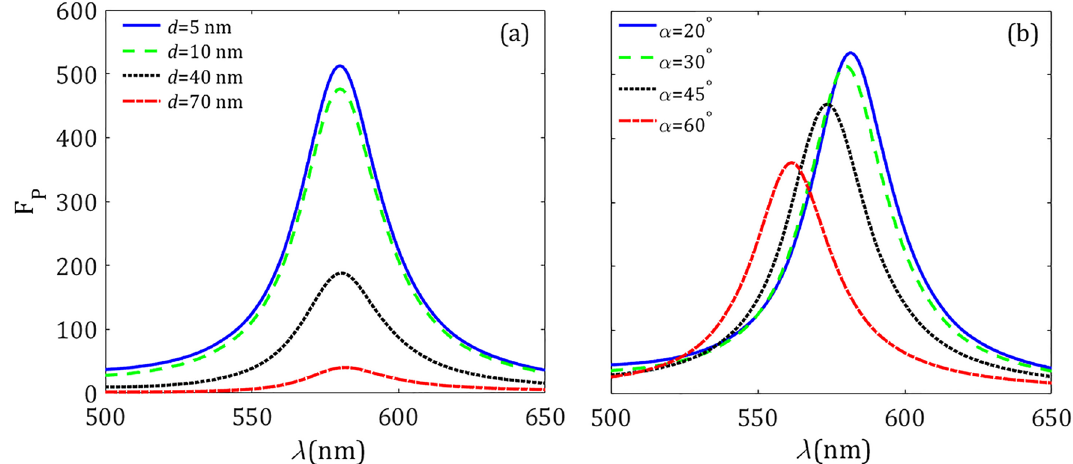
Figure 5. Purcell factor F P ( a ) for a different displacement d of the MD emitter along the axis of symmetry of 30 ◦ and R 70 nm fixed, and ( b ) for different angles of the tapered well, provided the resonator, keeping α = = 5 nm and R 70 that d = =